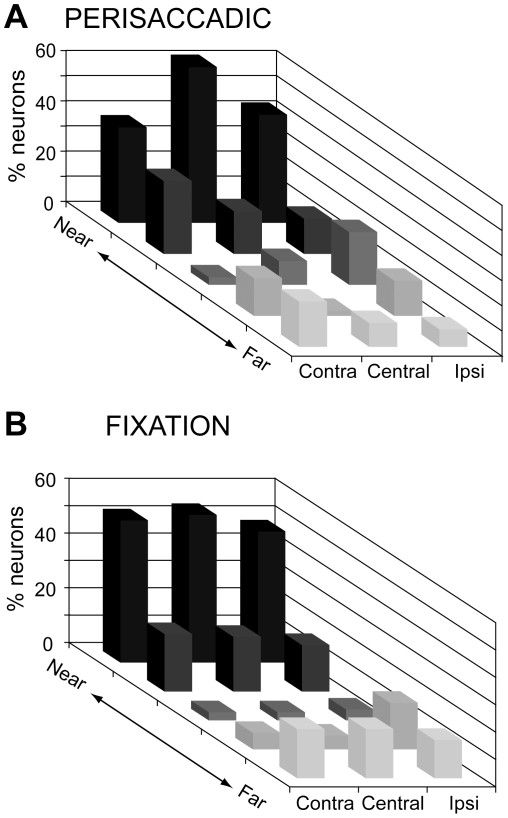
Preferred target positions in depth.Frequency histogram of the positions that neurons preferred in (A) perisaccadic (N = 91) and (B) fixation (N = 167) epochs. Ipsi and Contra indicate fixation position with respect to the recording hemisphere. Center refers to the straight ahead of the monkey. In both epochs there is a clear preference for near, reachable targets across all space.